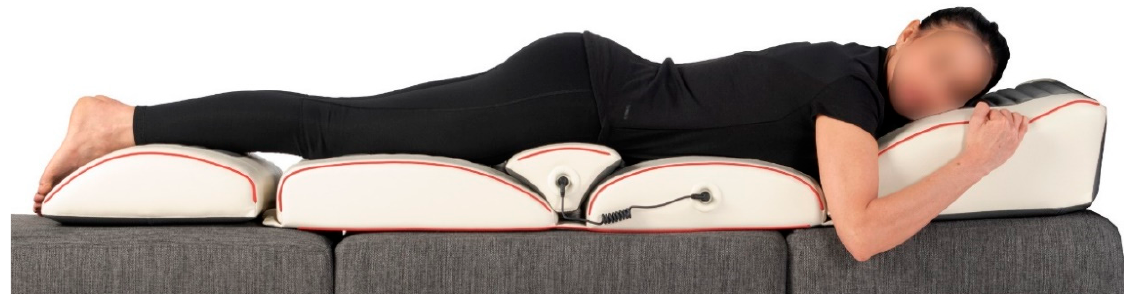
Figure 2. The position of the body on the device generating the vibration stimulus (illustrative photo) .